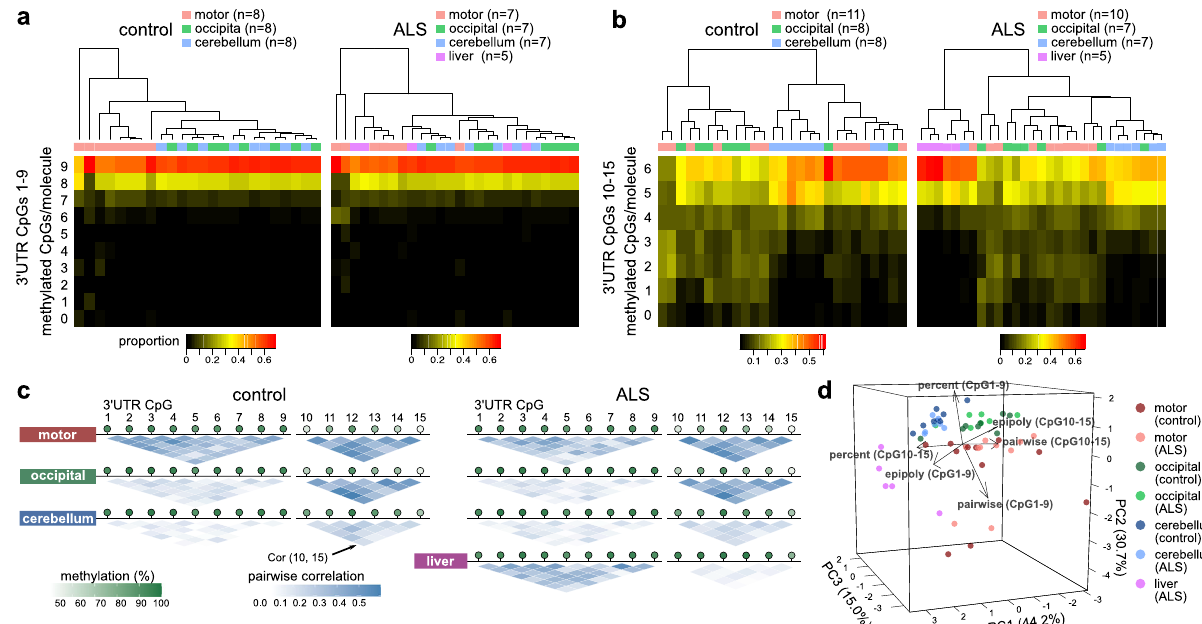
Fig. 5 DNA methylation status of TARDBP in different brain regions and liver tissues. a, b Proportions of the number of sequence reads classi fi ed by the number of CpGs methylated among nine CpG sites (3 ′ UTR CpGs 1 – 9) or six CpG sites (3 ′ UTR CpGs 10 – 15). c Methylation-linkage diagram of 3 ′ UTR CpGs 1 – 9 and 3 ′ UTR CpGs 10 – 15 showing the correlation of all CpG-site pairs in the target region. Green circles indicate the mean percentage of DNA methylation at each CpG site. d Principal component analysis using the mean methylation percentages, mean pairwise correlations, and epipolymorphism scores in 3 ′ UTR CpGs 1 – 9 and 3 ′ UTR CpGs 10 – 15. Eleven controls and 10 ALS patients were included in the analysis of 3 ′ UTR CpGs 10 – 15 in the motor cortex, fi ve ALS patients were included in the analysis of the liver, and seven ALS patients and eight controls were included in the other Fig. 6, TARDBP 3 ′ UTR CpGs 10 – 15 showed demethylation in the middle-aged ALS group compared with the control group, sug- gesting that the relationship between epigenetic age rather than chronological age and clinical features should be considered.